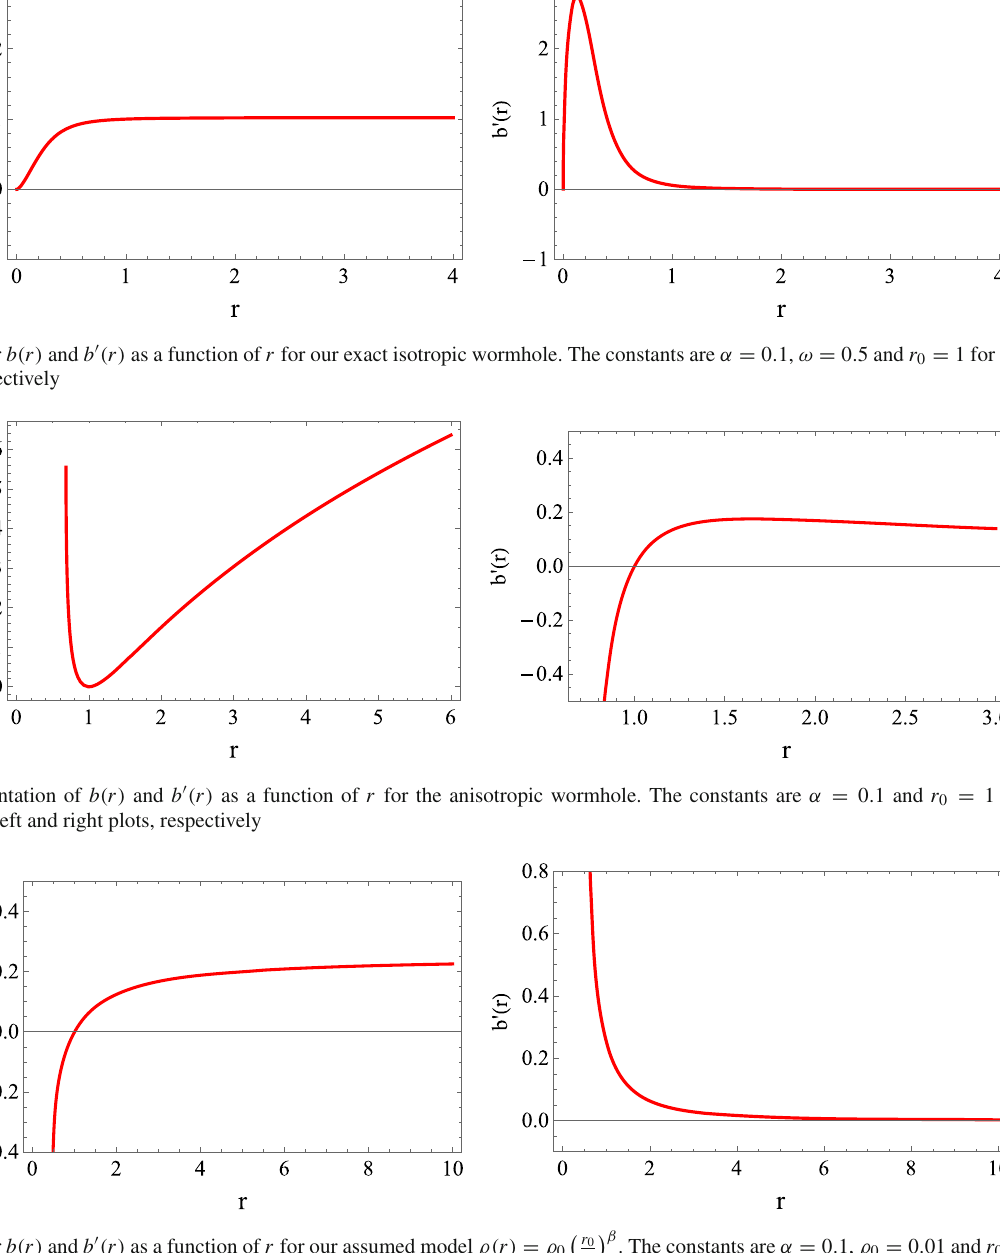
Fig. 3 Plots for b ( r ) and b (cid:7) ( r ) as a function of r for our assumed model ρ( r ) = ρ 0 with β = 4 for the left and right plots,